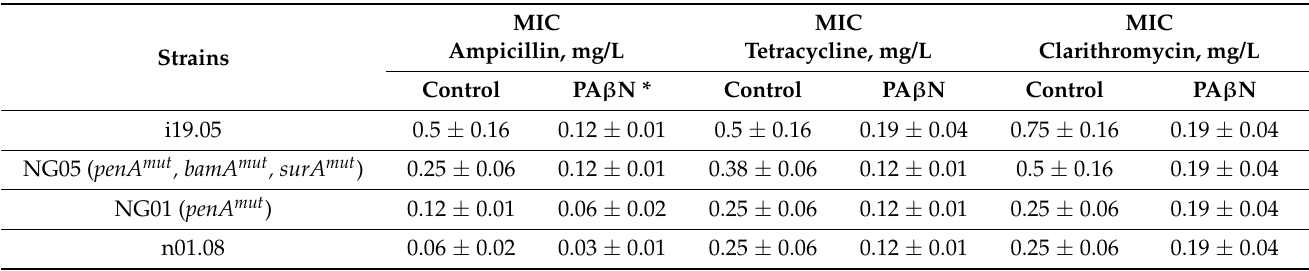
Table 1. MIC of antibiotics for the N. gonorrhoeae strains studied.